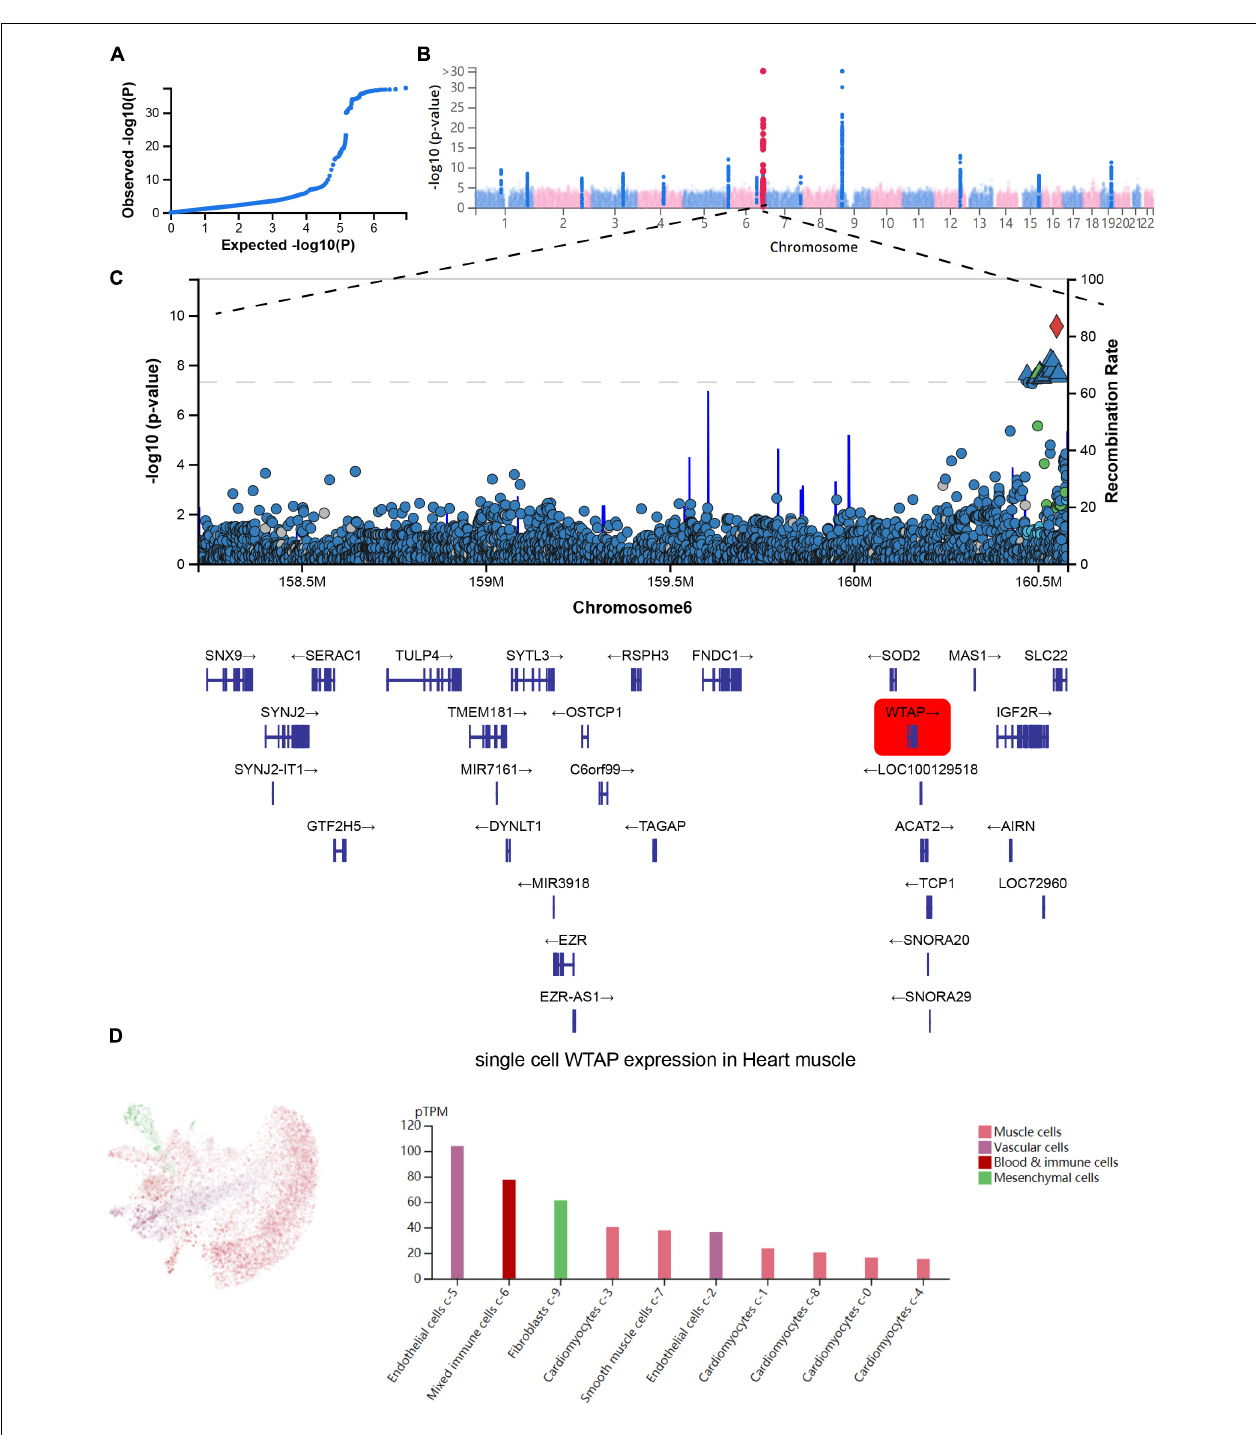
FIGURE 3 | Confirmation of functional importance of m6A regulators in MI. (A) Q-Q plot shows that significantly related SNP sites could be identified in GWAS data. (B) Manhattan plot representing meta-GWAS results. (C) SNP annotation of locus found that m6A regulatory gene WTAP was located in causal region on chromosome 6. (D) Single-cell sequencing of heart tissue showed that WTAP is widely expressed in heart tissues.